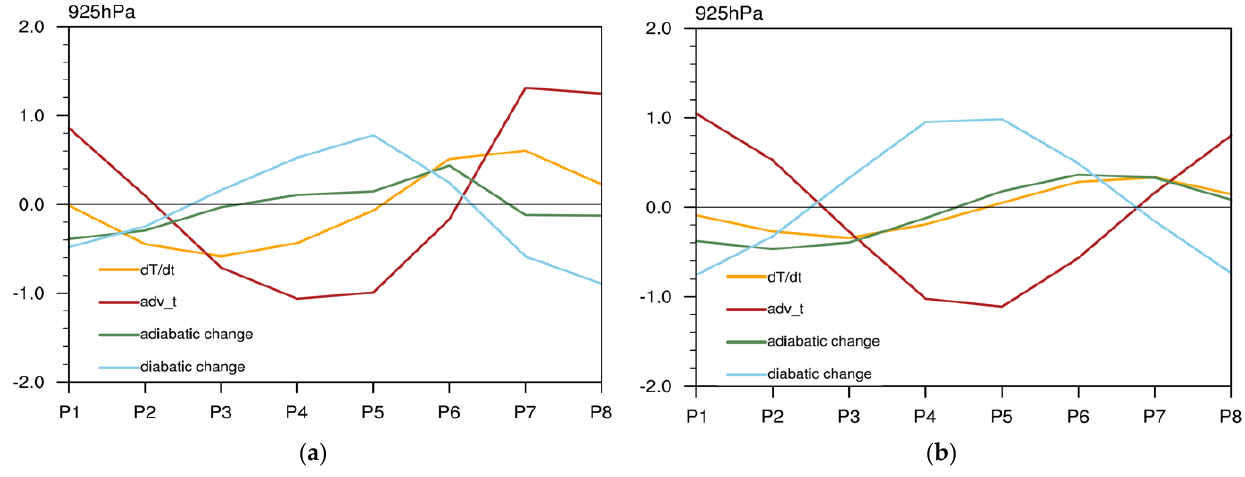
Figure 8. Thermodynamic equation budget (units: K d − 1 ) for the ( a ) 10–30-d and ( b ) 30–60-d filters at 925-hPa in southern China (20°–30° N, 105°–122.5° E).